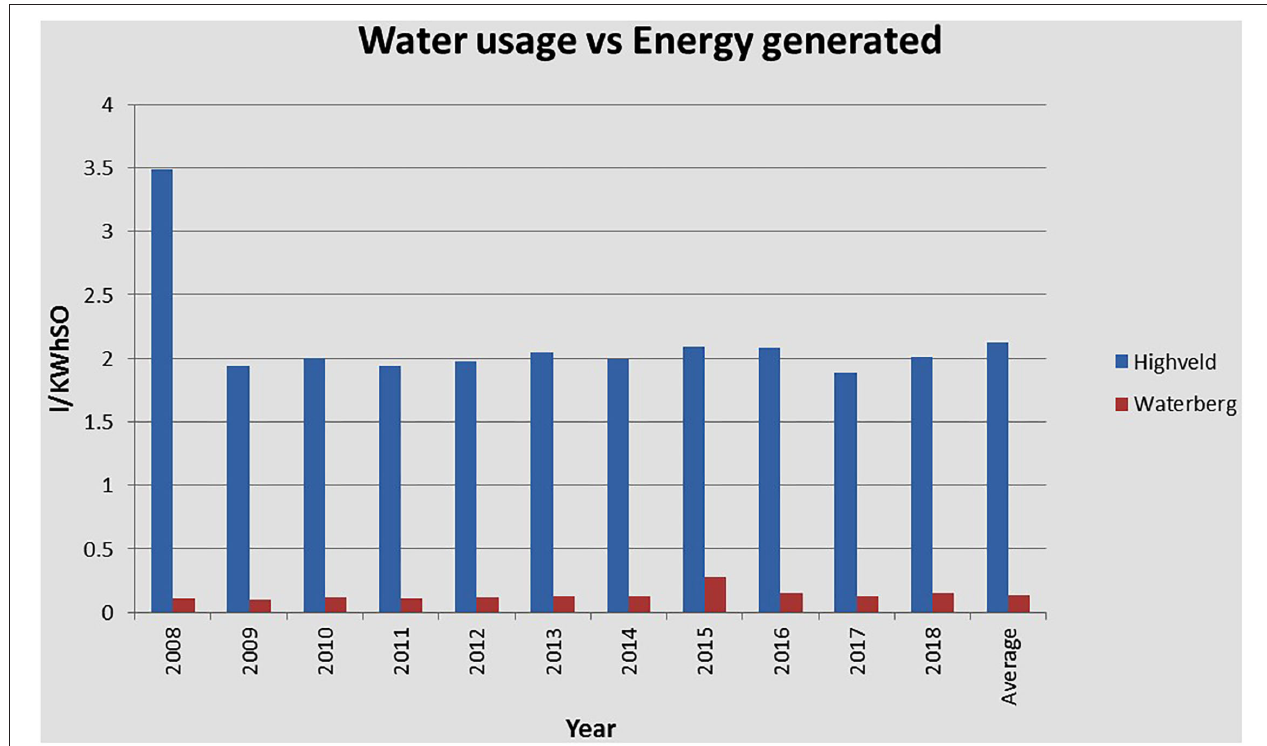
FIGURE 3 | Water used per Kilowatt per hour Sent Out for the Highveld and Waterberg stations. Source: Data from Eskom (2019).